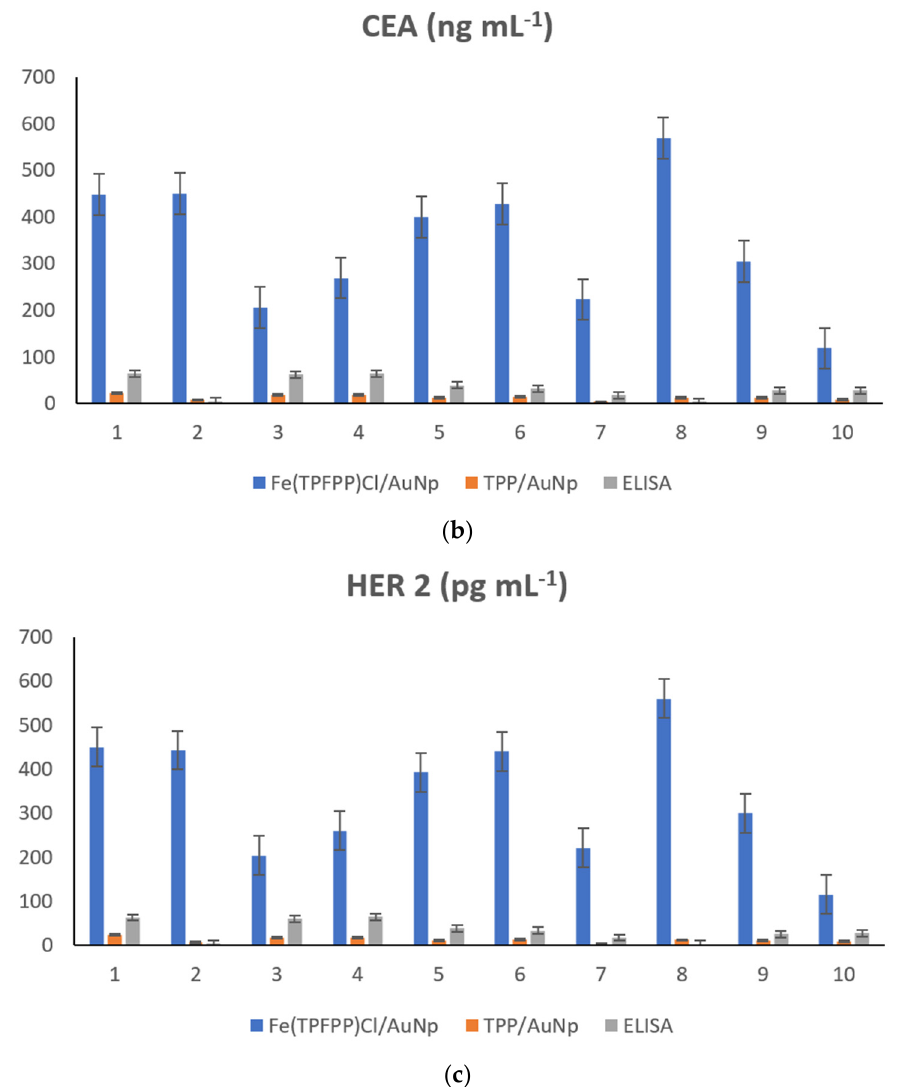
Figure 2. Quantitative determination of ( a ) CA15-3, ( b ) CEA and ( c ) HER2 in whole blood samples, using stochastic microsensors based on Fe(TPFPP)Cl/AuNp and TPP/AuNp, and the standard method - ELISA.